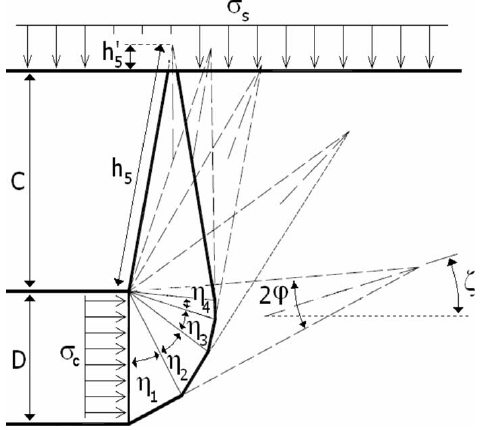
Figure 5. Conical multiblocks failure mechanism, Mollon et al. Fig. 2. Multiblock failure mechanism by Mollon et al. (cid:1) 2009 (cid:2) (cid:1) after Mollon et al. 2009 (cid:2)